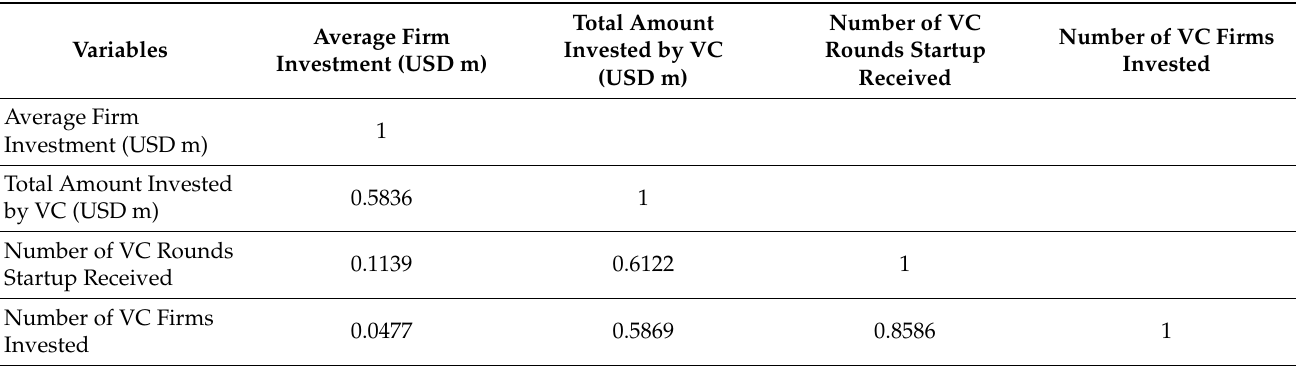
Table 3. Correlation Matrix for VC Backed